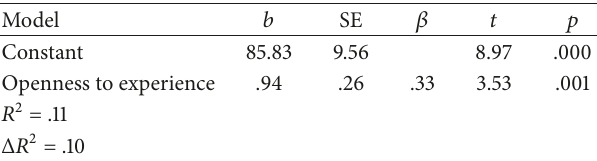
Table 7: Linear regression analysis indicating openness to experi- ence as the predictor of EI ( 𝑁 = 100